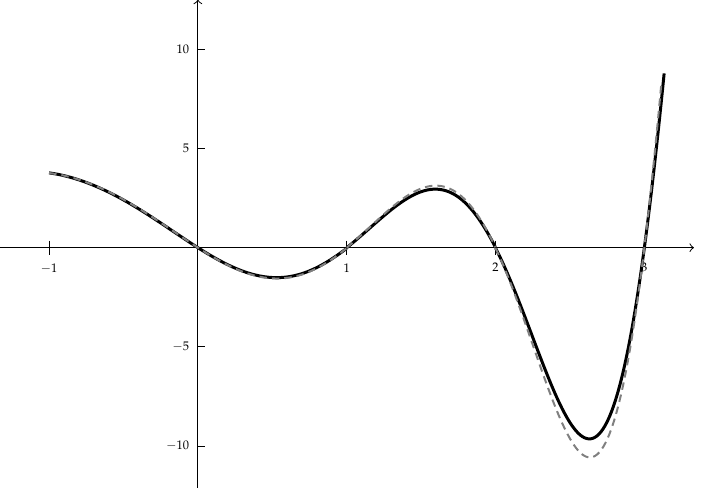
Figure 3. The gray-color curve represents the function in the left hand side in (54) for n = 100, and the black curve is the limiting function. Data: β = 7, c = 1/5, λ = 10 − 21 and j =